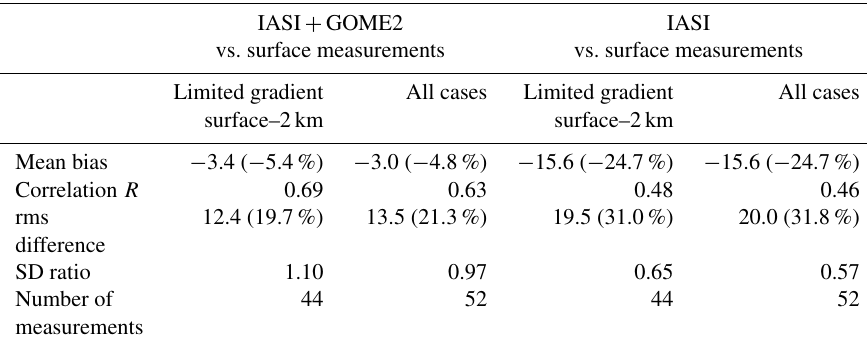
Table 2. Comparison of ozone in situ measurements at the surface from 11 EANET stations over the Japanese islands with IASI + GOME2 and IASI-only retrievals in the LMT, for two major ozone outbreaks on 4–9 April and 4–9 May 2009. We consider in situ measurements at 10:00 Japan Local Time (JLT) and the average of collocated satellite retrievals ± 1 ◦ of latitude and longitude. We only account for coincidences with both IASI + GOME2 and IASI retrievals. Biases and rms differences are given in ppb mixing ratio and percentage in parentheses. Scatter plots of these datasets are provided in Fig. 2. A selection of the data with limited gradient (lower than 10ppbkm − 1 in absolute value) of ozone between the surface and 2km (according to CHASER analyses) is considered. IASI + GOME2 IASI vs. surface